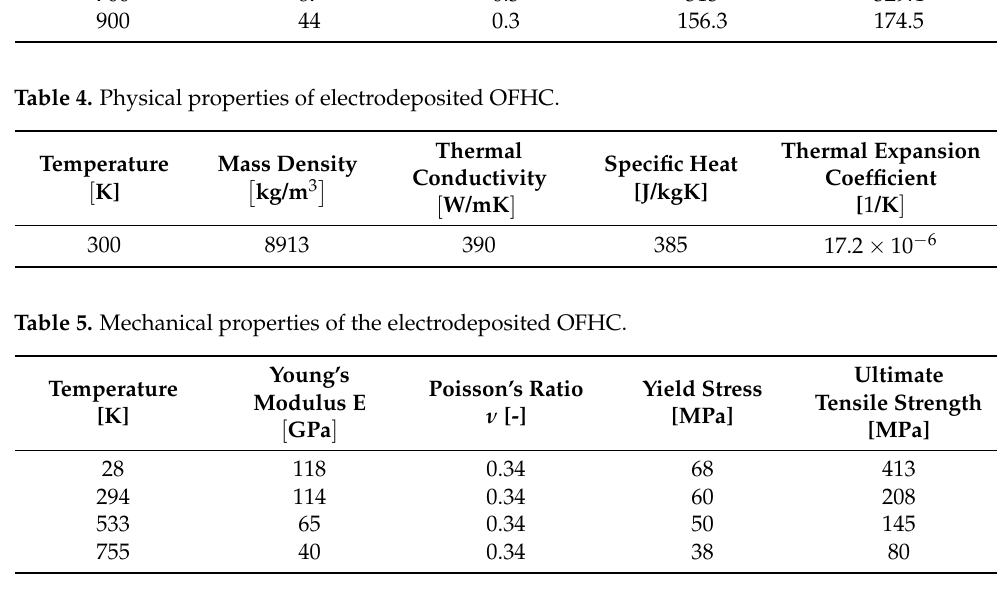
Table 2. Physical and thermal properties of CuCrZr [16].